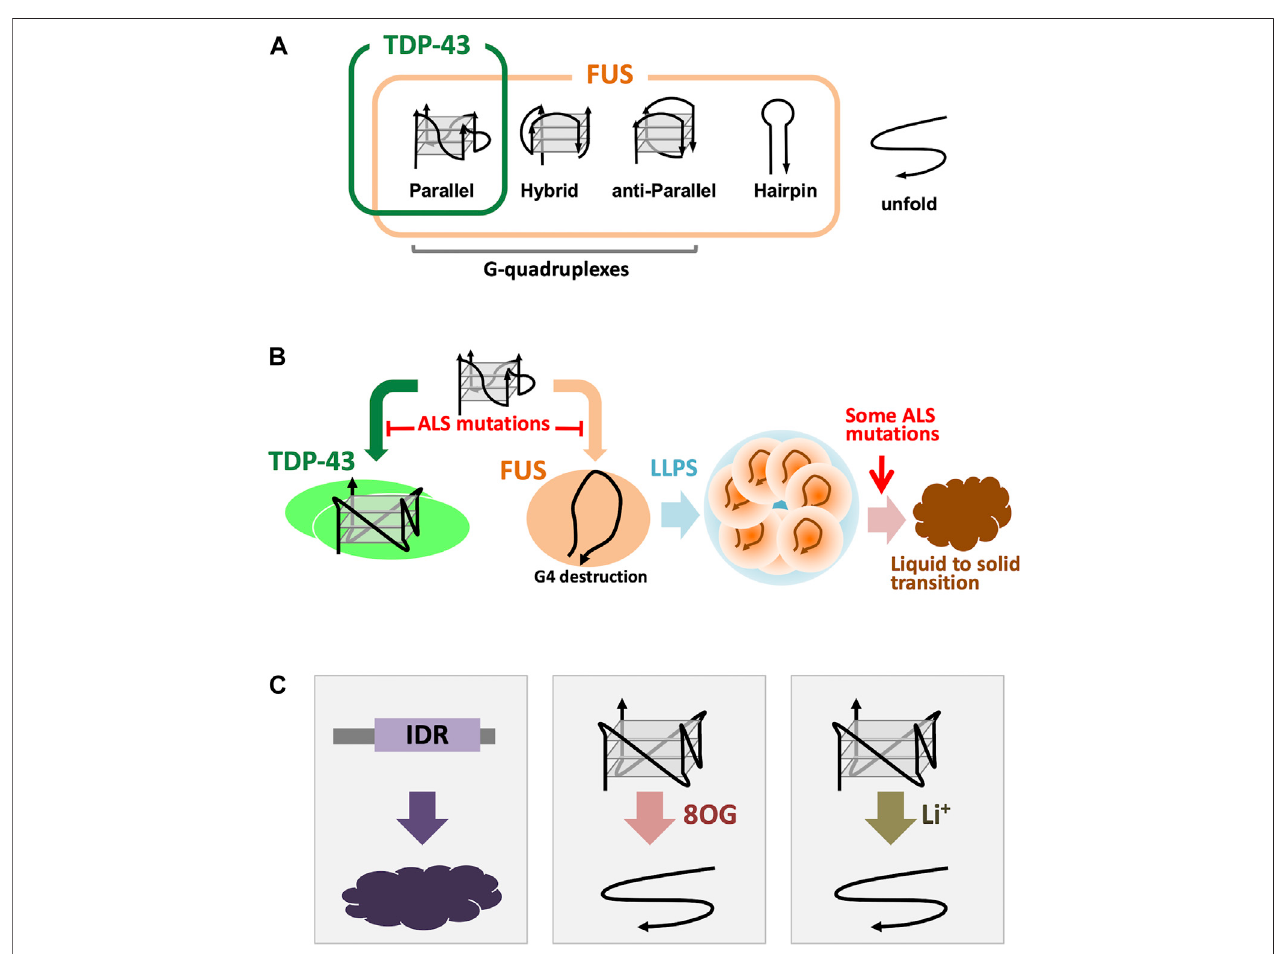
FIGURE 2 | ALS-linked G4 binding proteins. (A) , Binding speci fi city of TDP-43 and FUS. TDP-43 can bind only for the parallel-stranded G4-DNA/RNAs, however, FUS binds to parallel, hybrid, and even G-rich hairpin forms (Ishiguro et al., 2021). (B) , Different G4 binding modes for TDP-43 and FUS. TDP-43 protects and stabilizes the G4 structure, while FUS destabilizes the G4 conformation and recreates it into a “ terminal associated ” con fi guration. In both cases, the G4-protein interaction was inhibited by introducing amino acid substitutions from ALS patients (Ishiguro et al., 2021). In some FUS mutations have been found that promotion of the phase transition of liquid to solid phase of the droplet formed by LLPS (Ishiguro et al., 2021). (C) , Concerned risks for G4s and G4 binding proteins. Low-complexity IDRs have considered to be tended to be aggregated (van der Lee et al., 2014; Taylor et al., 2016). 8OG produced by oxidation of guanine interferes with the normal formation of G4. Li+ is the same monocation as K+ and Na+, but it is known that it may not contribute to the structural stabilization of